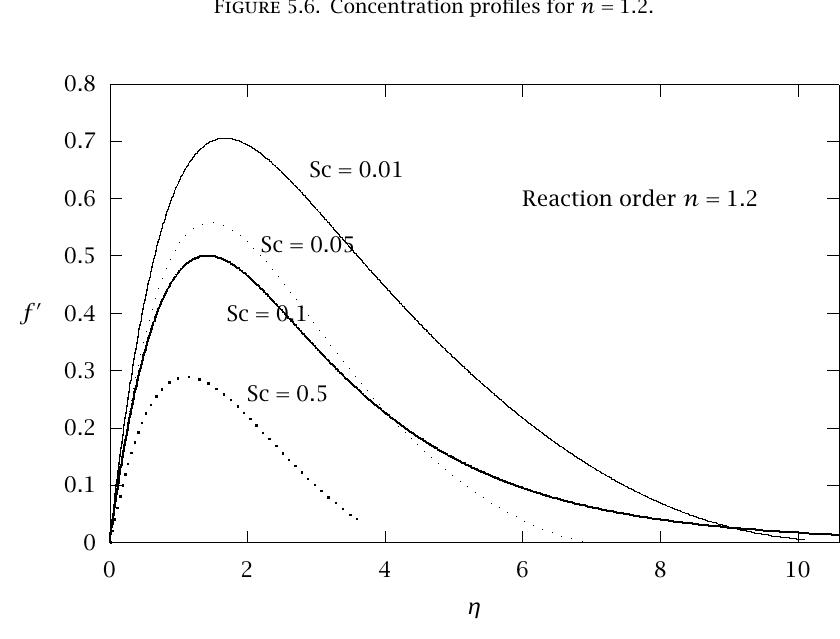
Figure 5.7 . Velocity profiles for n = 1 .